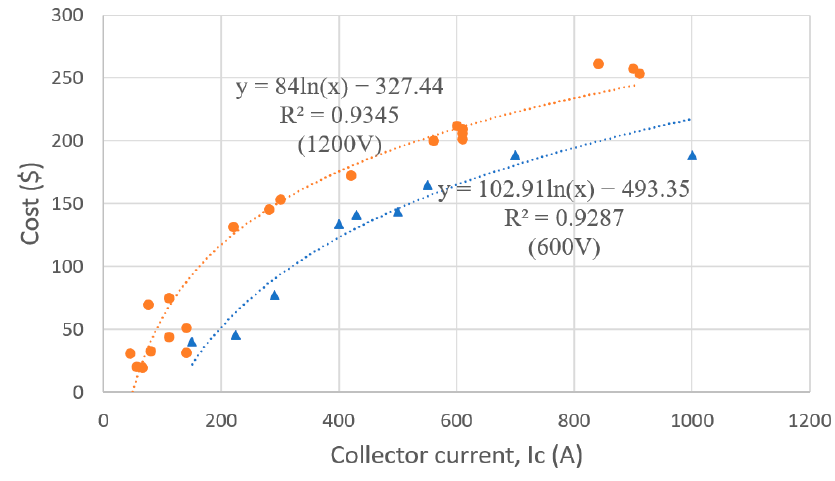
Figure 17. Cost model of IGBT.